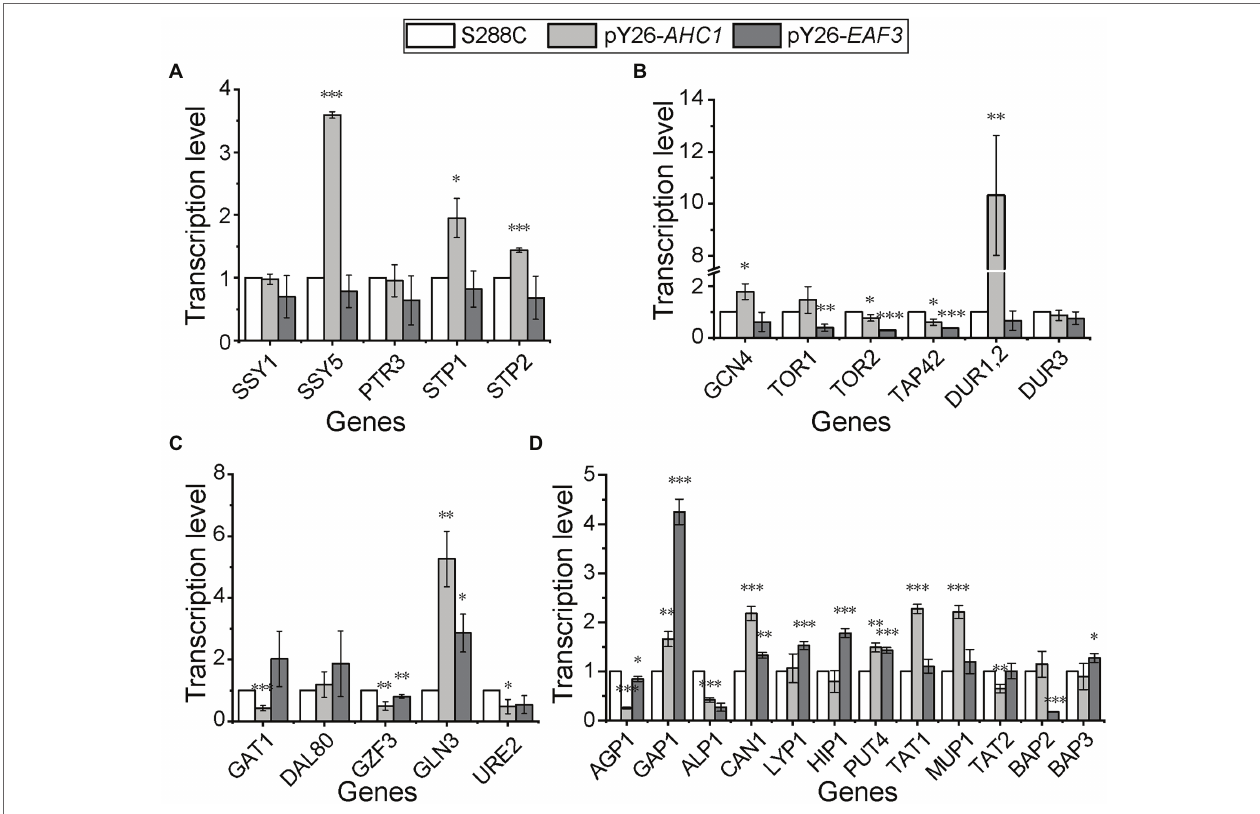
FIGURE 4 | Relative transcription levels of key genes for nitrogen metabolism. (A) Relative transcription levels of SPS sensor system-related genes. (B) Relative transcription levels of genes related to the general amino acid control (GAAC) pathway, the TOR pathway, and urea metabolism. (C) Relative transcription levels of NCR genes. (D) Relative transcription levels of amino acid transporters. Genes with a transcriptional fold change greater or less than 1 were considered upregulated or downregulated, respectively. Transcription levels were normalized against the housekeeping gene ACT1 and S288C as controls. Results are mean (M) ± standard deviation (SD) of three biological replicates. Statistical significance was determined by unpaired parametric two-tailed Welch’s t -test with 95% confidence (* p < 0.05, ** p < 0.005, *** p <